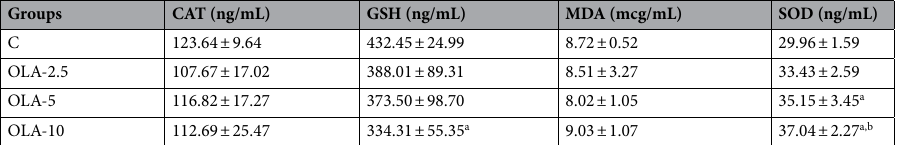
Table 4. The levels of oxidative stress biomarkers in rat’s testes. Definition of abbreviations: OLZ-2.5 2.5 mg kg −1 olanzapine-administered rats for 28 days group, OLZ-5 5 mg kg −1 olanzapine-administered rats for 28 days group, OLZ-10 10 mg kg −1 olanzapine-administered rats for 28 days group. Results were given as mean ± standard error. All data were expressed as mean ± standard error. a Different from control group (p < 0.05). b Different from OLZ-2.5 (p ≤